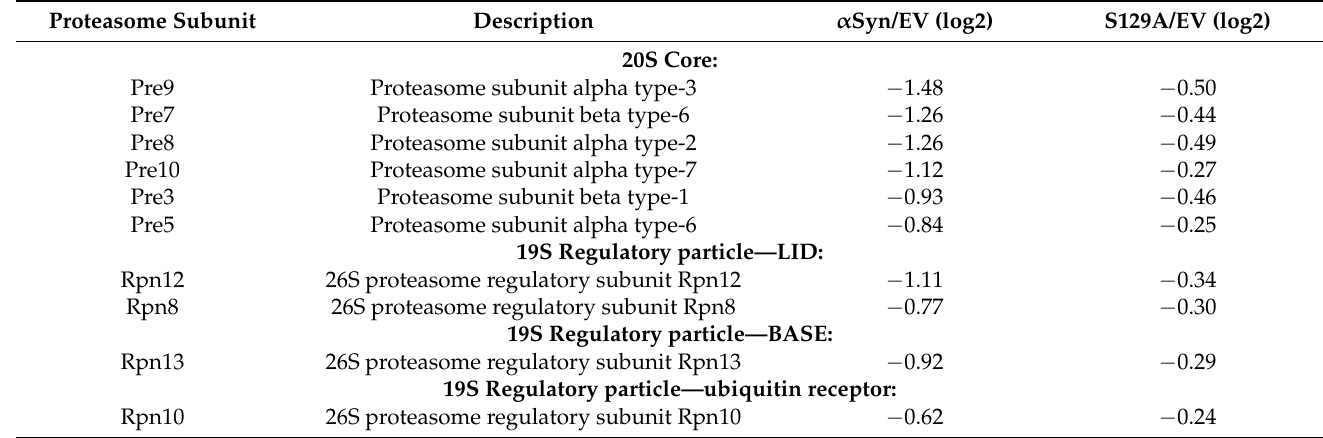
Table 3. Fold change of proteasome subunits upon expression of α Syn or S129A relative to the empty vector (EV) control. Proteasome Subunit